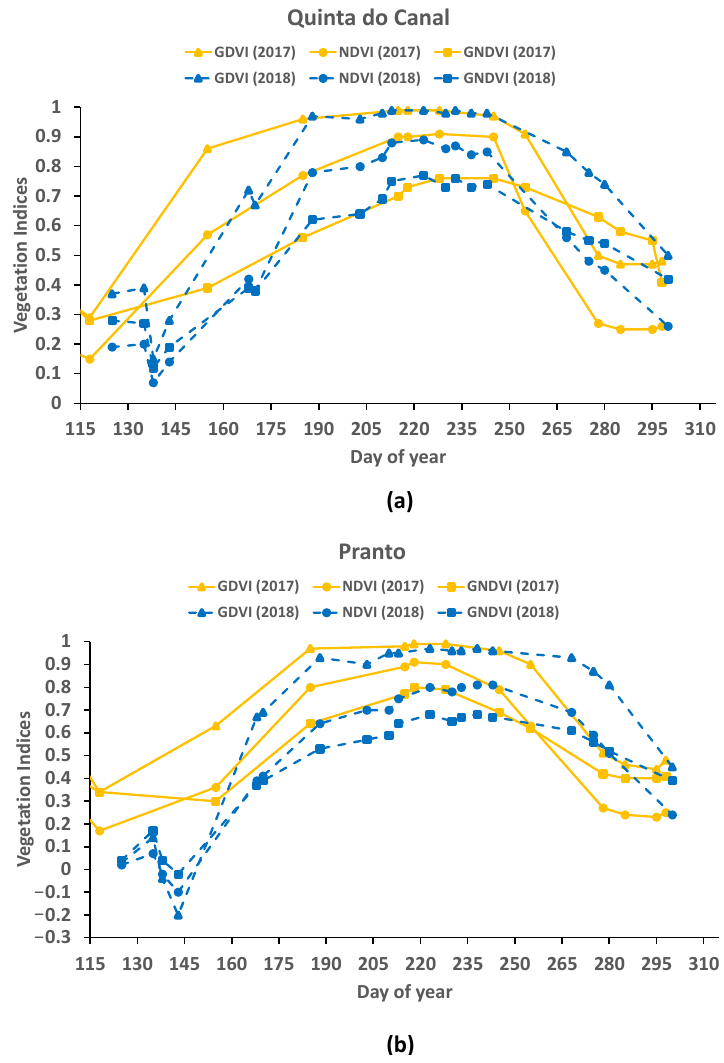
−−− Figure 3. Temporal variation of NDVI, GNDVI and GDVI average values in 2017 and 2018 calculated for the selected irrigated rice field plots at ( a ) Quinta do Canal (Figure 1a), sowing dates: 128 (2017) and 132 (2018); and ( b ) Pranto valley (Figure 1b), sowing dates: 132 (2017) and 143 (2018), using available Sentinel-2 satellite imagery.